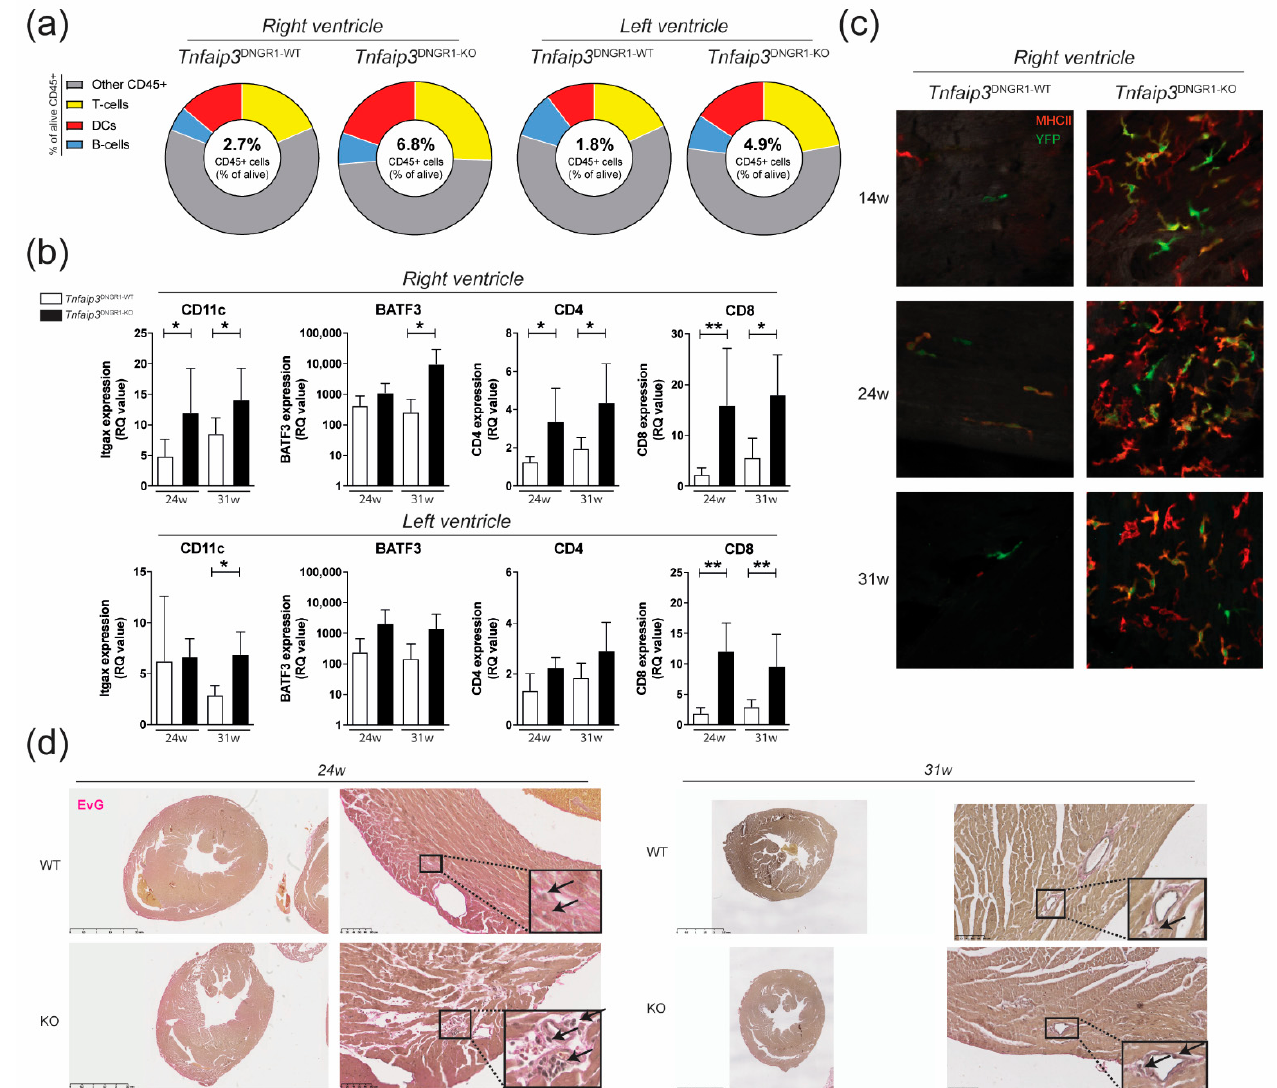
Figure 1. Increased myocardial infiltration of dendritic cells (DCs) in the right ventricle (RV) of Tnfaip3 DNGR1 ‐ KO mice. ( a ) Flow cytometry analysis for CD45+ cells (alive CD45 + cells), DCs (CD3 ‐ /CD19 ‐ , MHC ‐ II+CD11c+), T cells (CD3+) and B cells (CD19+) in separately measured right and left ventricle cell suspensions from hearts of Tnfaip3 DNGR1 ‐ WT/KO mice; ( b ) mRNA expression (relative to the glyceraldehyde ‐ 3 ‐ phosphate dehydrogenase (GAPDH) housekeeping gene) of DC markers CD11c and BATF3, and the T cell subset markers CD4 and CD8 in 24 ‐ and 31 ‐ week ‐ old Tnfaip3 DNGR1 ‐ KO and wild-type (WT) control mice; ( c ) whole mount analysis of right ventricle staining for YFP (green) and MHCII (red) in age 14 ‐ , 24 ‐ or 31 ‐ week ‐ old Tnfaip3 DNGR1 ‐ KO mice. Results are presented as mean values + standard deviations of 4–6 mice per group. * p < 0.05, ** p < 0.01; ( d ) Elastin van Gieson (EvG) ‐ stained whole heart section histology of Tnfaip3 DNGR1 ‐ WT and Tnfaip3 DNGR1 ‐ KO mice for representative sections. Scale in left panels is 2.5 mm and in right panels 100 μ m. Arrows indicate lymphocytes.